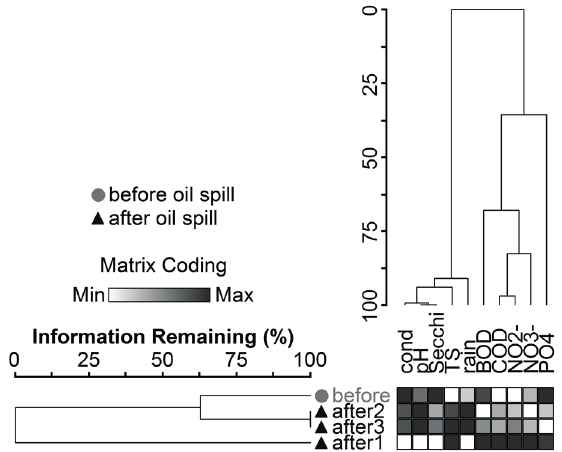
Figure 1 - Dendrogram of similarity showing environmental data before and after the oil spill in Negro River,